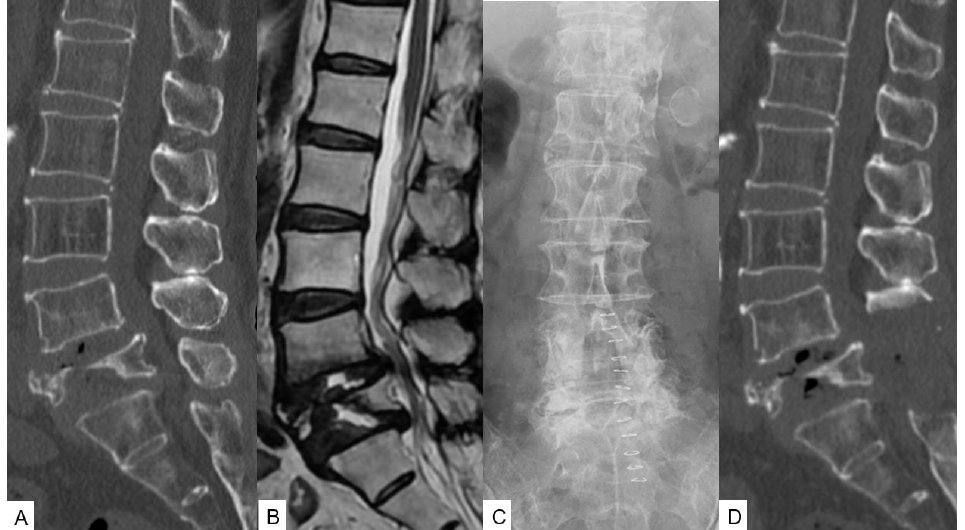
Figure 1. Pre- and postoperative images of the first surgery. ( A ) Preoperative mid-sagittal reconstruction CT; ( B ) Mid-sagittal MRI T2-weighted image; ( C ) Postoperative radiogram; ( D ) Postoperative mid-sagittal reconstruction CT.